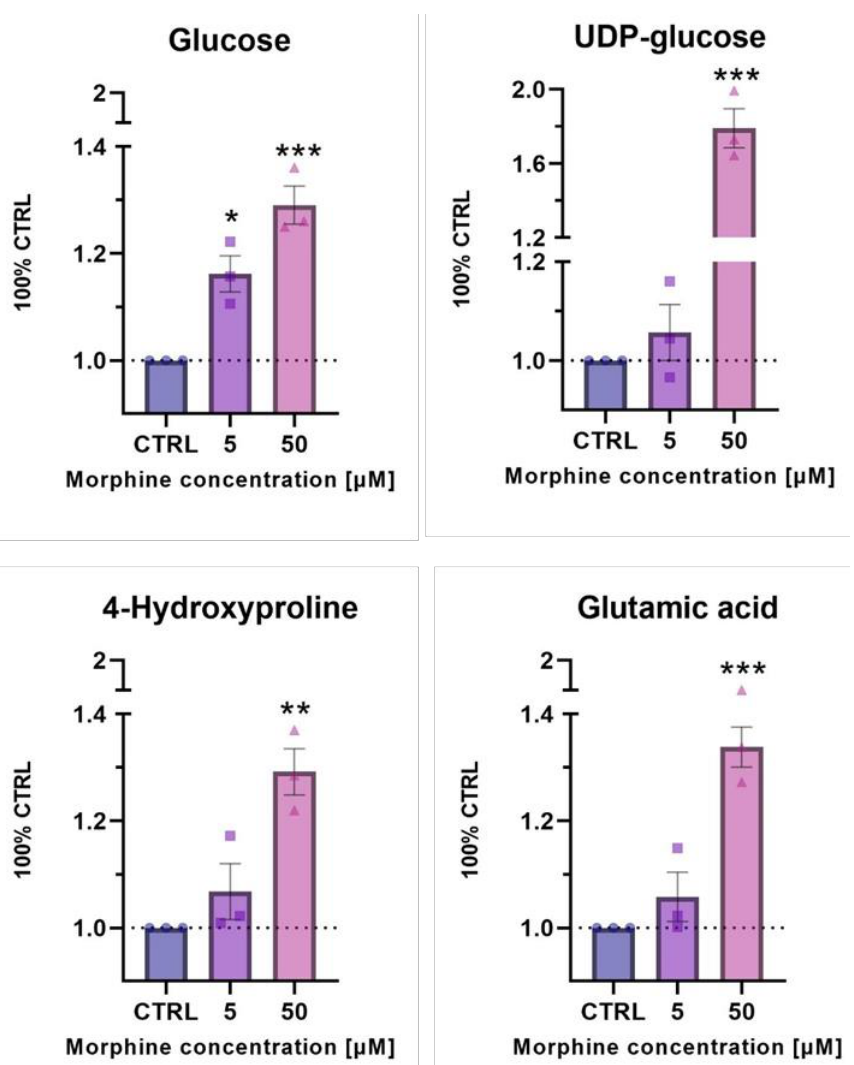
Figure 7. Relative levels of metabolites involved in HIF1 target pathway (glucose and UDP-glucose) and ECM remodeling process (4-hydroxyproline and glutamic acid) after 24 h of exposure to morphine at 5 and 50 µ M on HBMECs. Geometric shapes represents individual values. Statistical analysis for the morphine effects was evaluated with an unpaired t -test. Significant p -values: * p -value ≤ 0.05; ** p -value ≤ 0.01 and *** p -value ≤ 0.001.